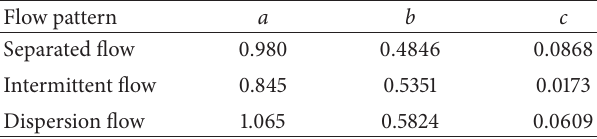
Table 6: Different coefficient of a , b, and c .